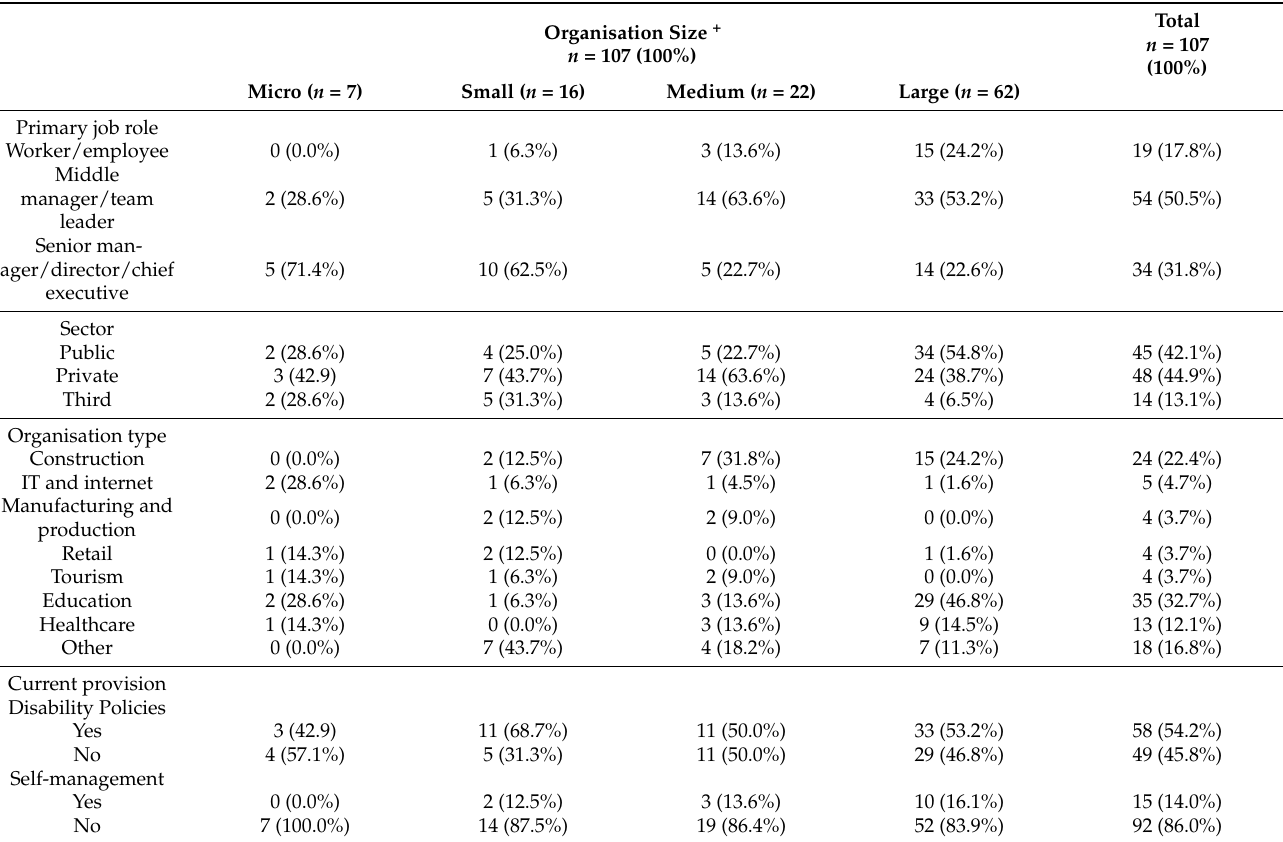
Table 3. Employer characteristics and